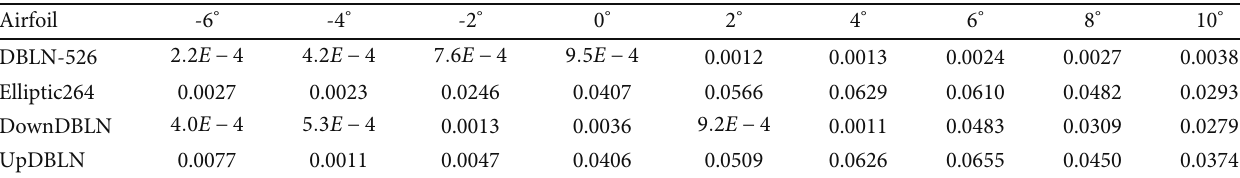
Table 5: Comparisons of Δ Cl at Re = 0 : 8 × 10 6 .